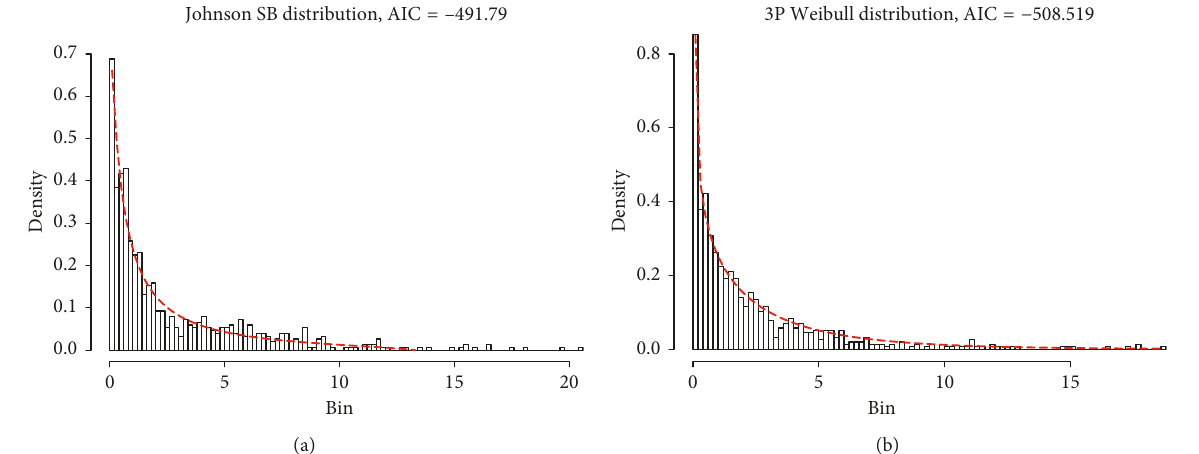
Figure 2: Probability distributions fitted for SPTI. (a) Astor. (b) Chilas.